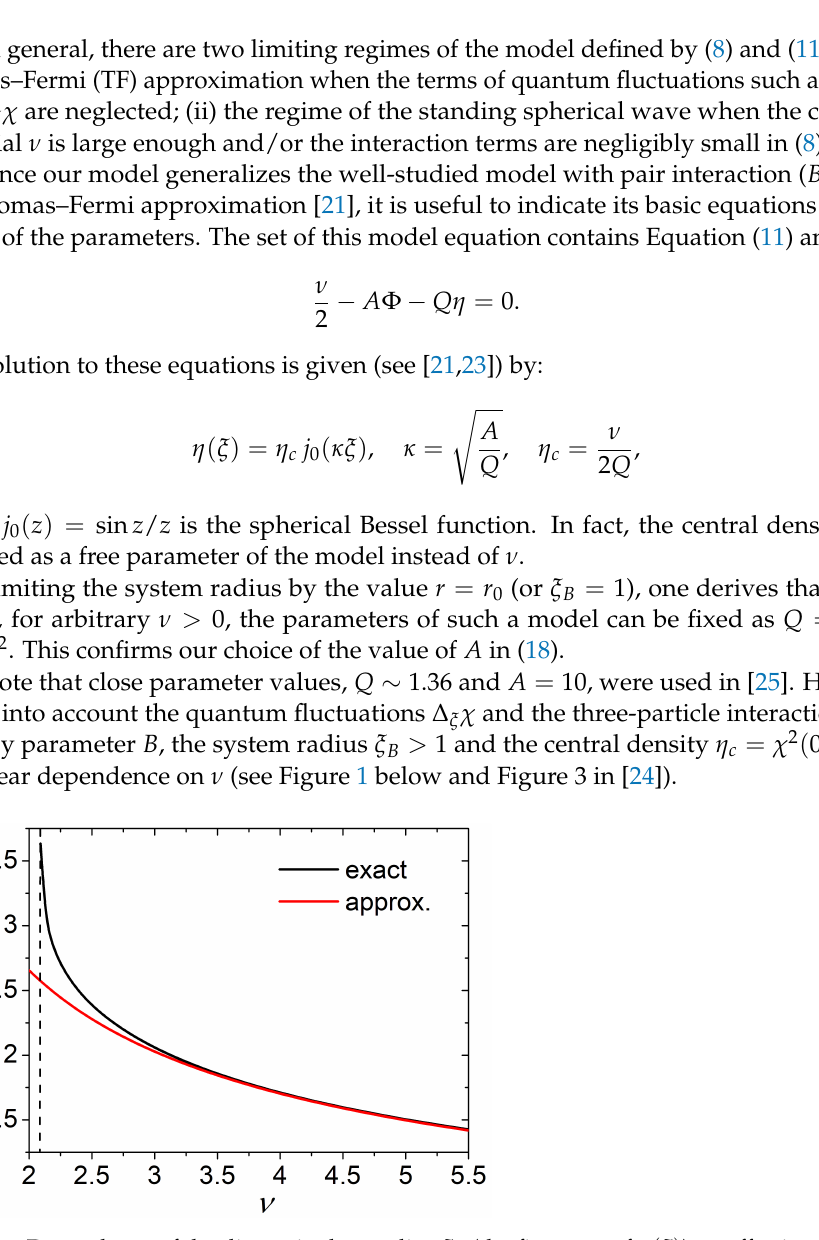
Figure 1. Dependence of the dimensionless radius ξ B (the first zero of χ ( ξ ) ) on effective chemical potential ν . Here, A = π 2 , Q = 1, B = 20, ν min (cid:39) 2.09. The approximation (27) is built at w = 0.6. The chemical potential µ = 0 at ν (cid:39) 2.263, defines the lower limit of applicability of the